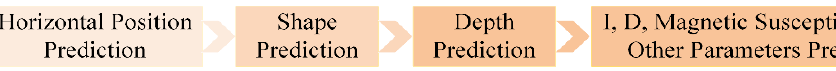
Figure 4. Steps of the prediction process.